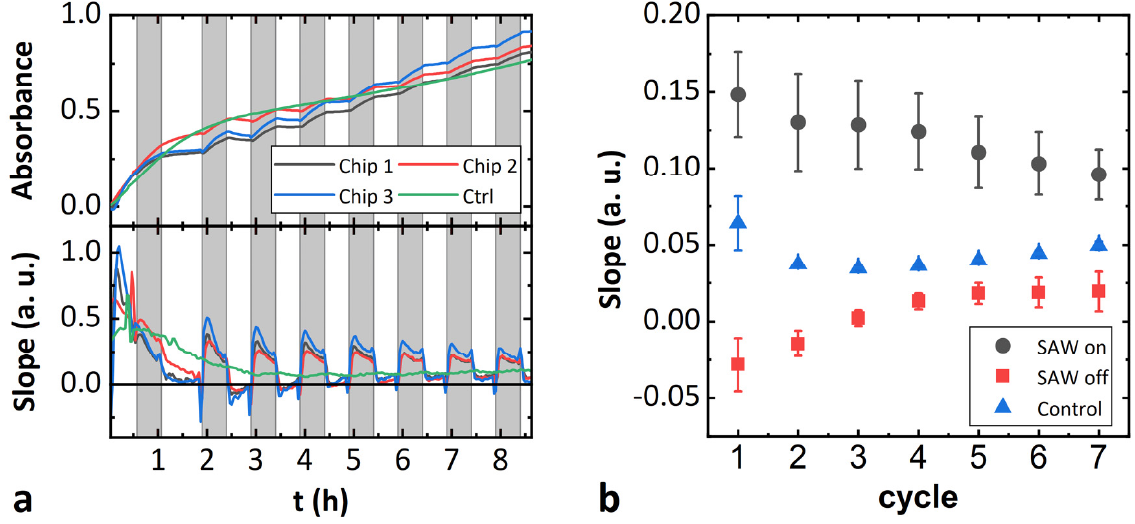
Figure 5. Influence of a SAW standing wave field on enzyme activity. ( a ) Time evolution of the absorbance and the first derivative thereof. A SAW is applied during the gray-shaded time intervals. ( b ) Time-averaged slope for the intervals with and without SAW treatment. Error bars represent the standard deviation of the three samples.